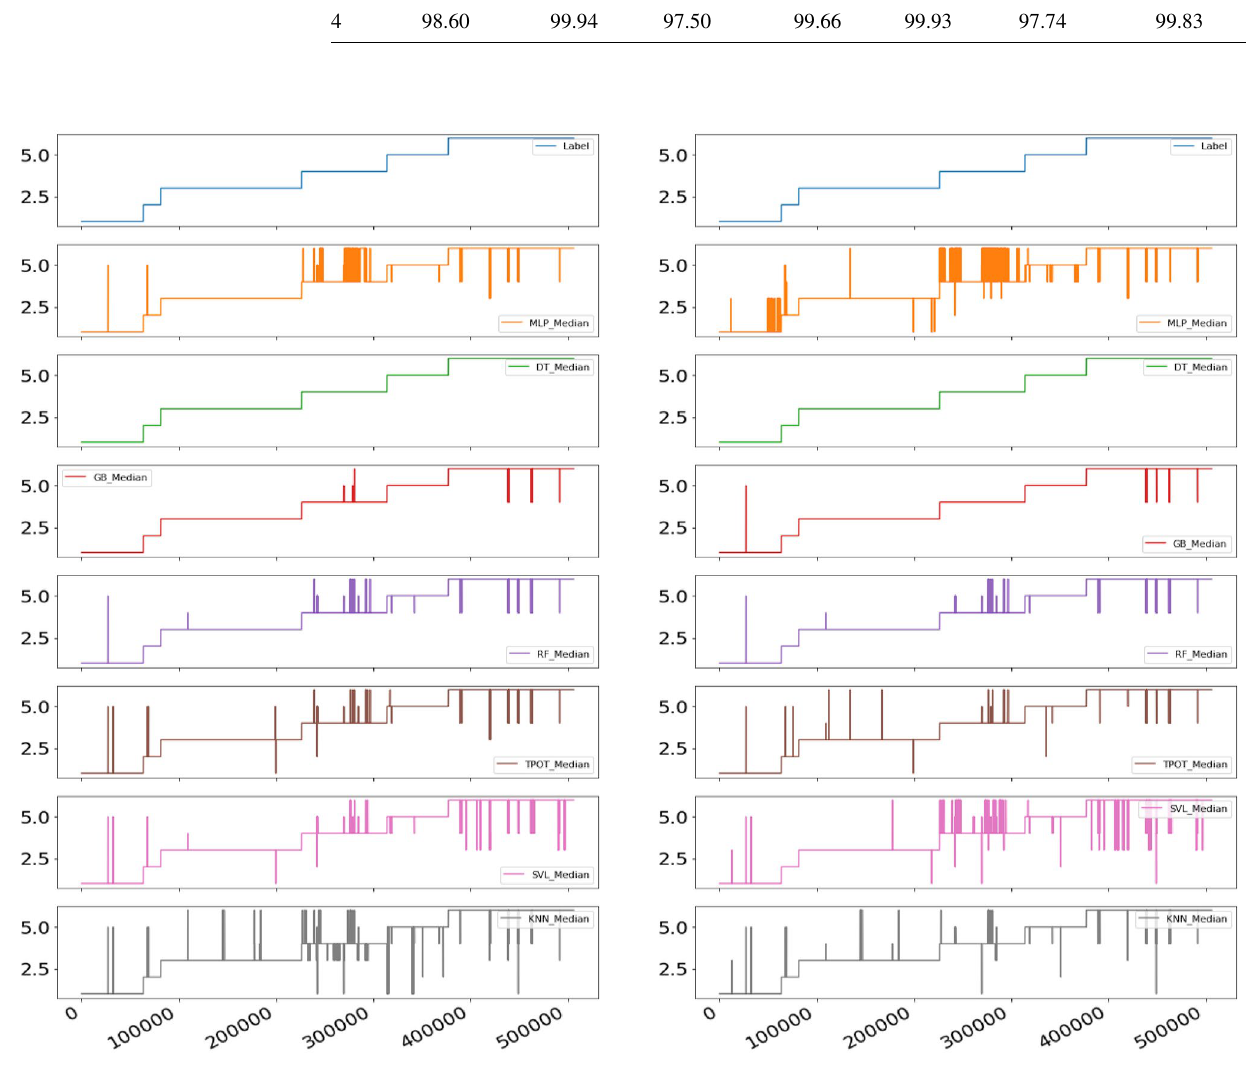
Fig. 6 Prediction from Case 1 Fig. 7 Prediction from Case